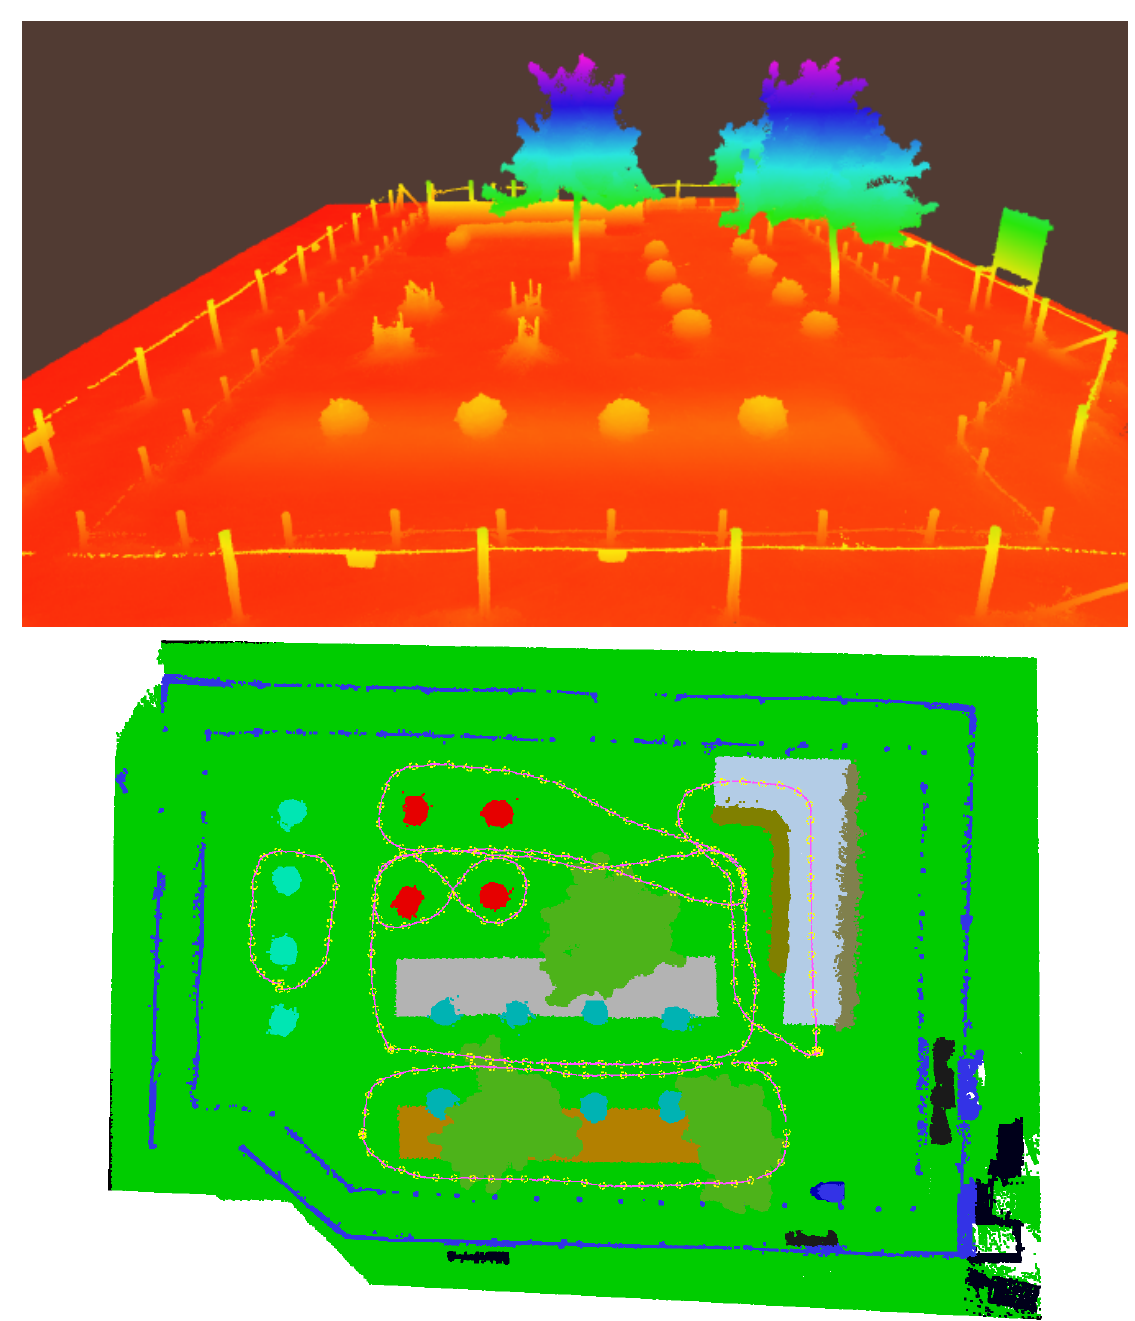
Figure A1. Trimbot Garden 2017 GT dataset [29]. ( Above ): point cloud with color-encoded height. ( Below ): semantic point cloud with trajectories (magenta line) and camera centers